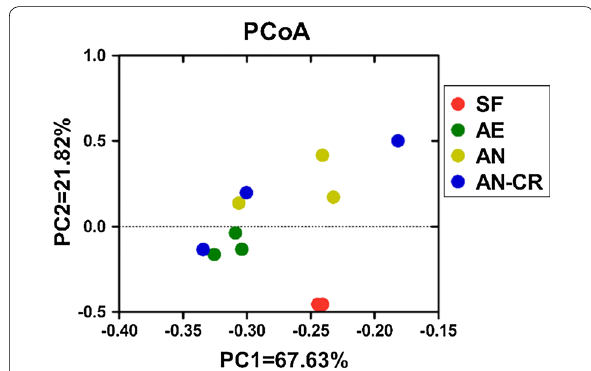
Fig. 3 Principal coordinate analysis (PCoA) of active bacterial communities in all groups. SF sows’ fecal group, AE aerobic group, AN anaerobic group, AE-CR anaerobic-cryopreserved group